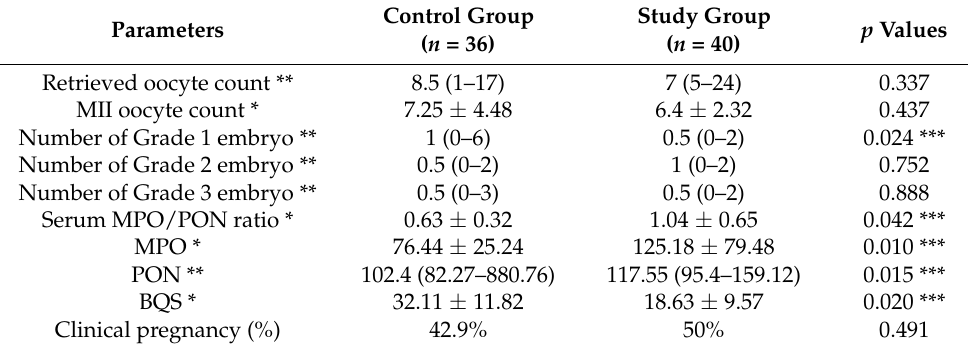
Table 2. Comparison of in vitro fertilization outcomes and laboratory